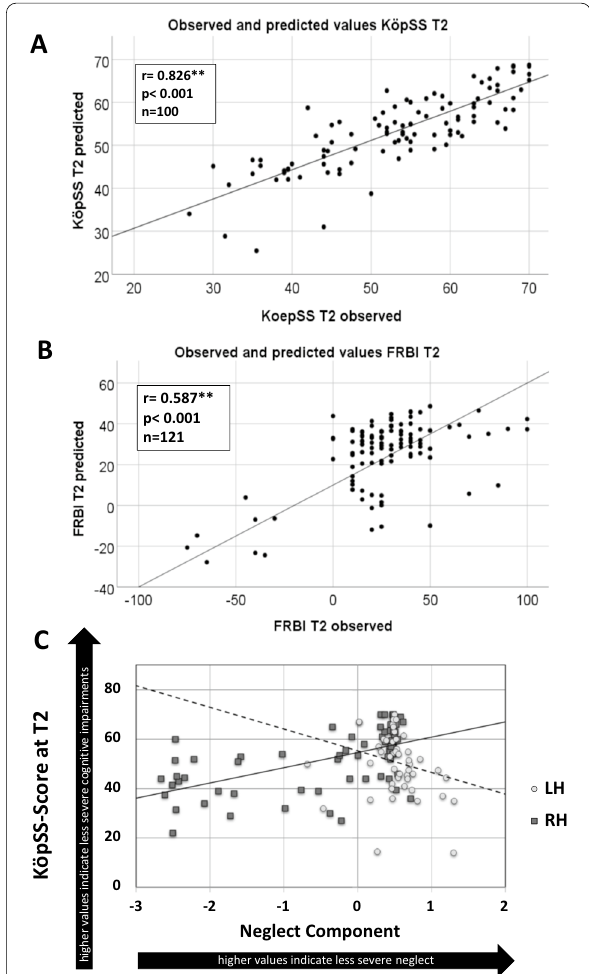
Fig. 3 Distributions of observed and predicted scores for the cognitive and functional outcomes and the moderation effect of the hemispheres for cognitive outcome. A , B Visual depiction of the values predicted by the multiple regression models and actually observed values for cognitive (KöpSS at T2, A ) and functional (FRBI at T2, B ) outcome. For both outcomes, there was a significant correlation between predicted and observed values. C Cognitive outcome (KöpSS) at discharge (T2) predicted by the Neglect Component for LH (n 41) and RH stroke patients (n 59). The X-axis = = displays individual component scores of the Neglect Component as z-transformed scores. The y-axis shows the KöpSS scores at discharge (T2). A significant moderator effect revealed an impact of the Neglect Component for RH stroke patients only (depicted by the continuous trend